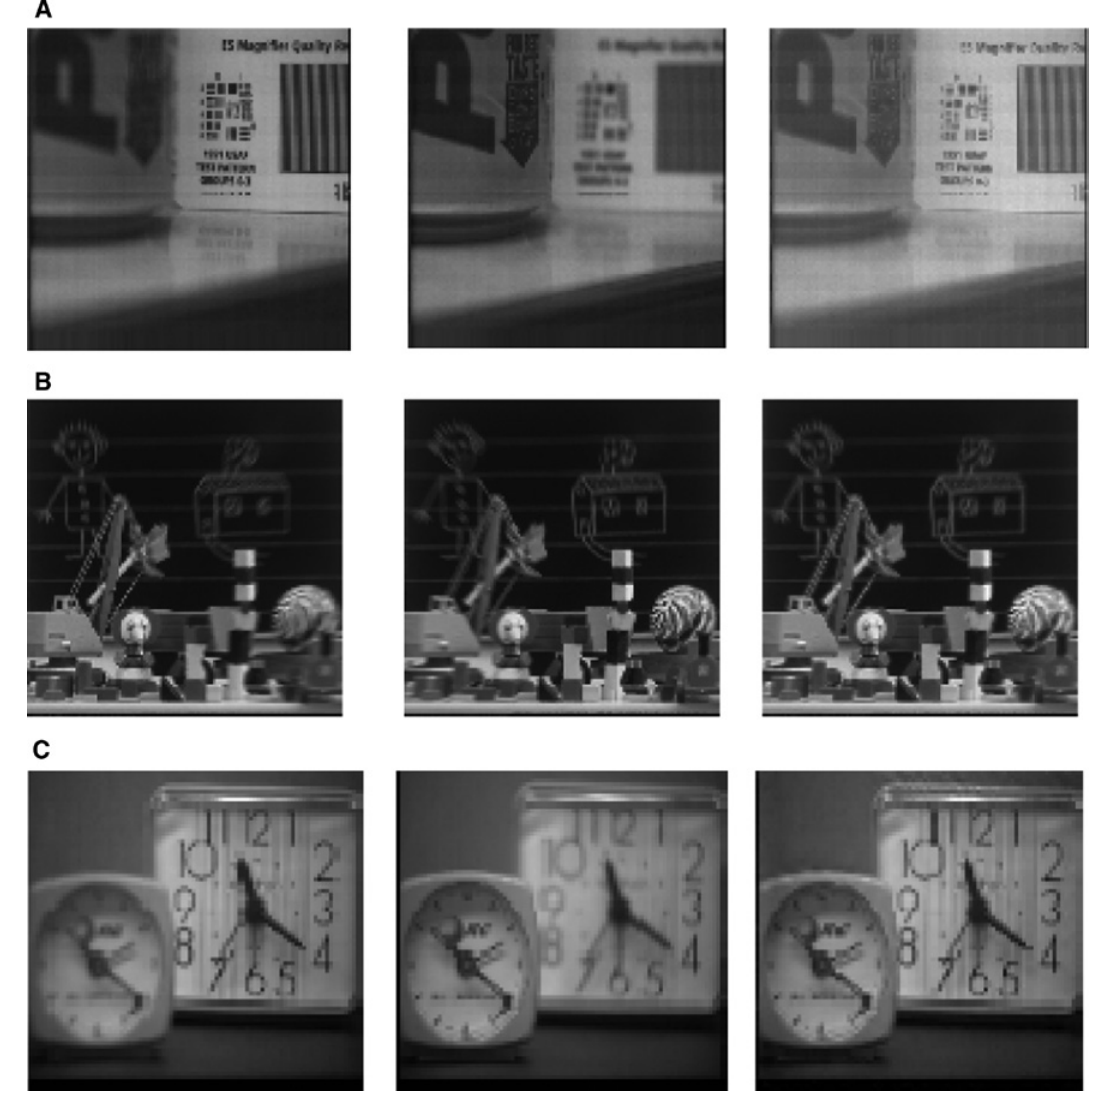
Figure 4: Simulation Results of the Proposed Algorithm. (A) Fusion algorithm based on weighted ratios and the weighted gradient ( T = 4) (source image A, source image B, fusion image). (B) Fusion algorithm based on weighted ratios and the weighted gradient ( T = 4) (source image A, source image B, fusion image). (C) Fusion algorithm based on weighted ratios and the weighted gradient ( T = 5) (source image A, source image B, fusion